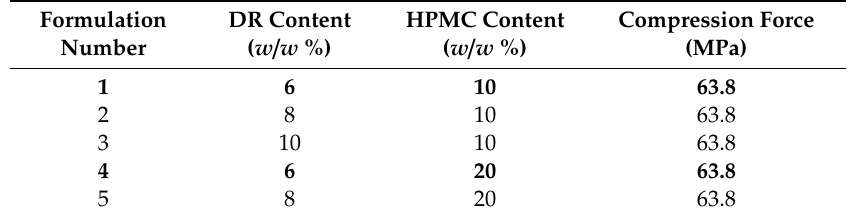
Table 1. Experimental conditions applied for the tablet manufacturing. Additional settings are displayed in italics. Settings chosen for validation are displayed in bold. DR = drotaverine; HPMC = hydroxypropyl